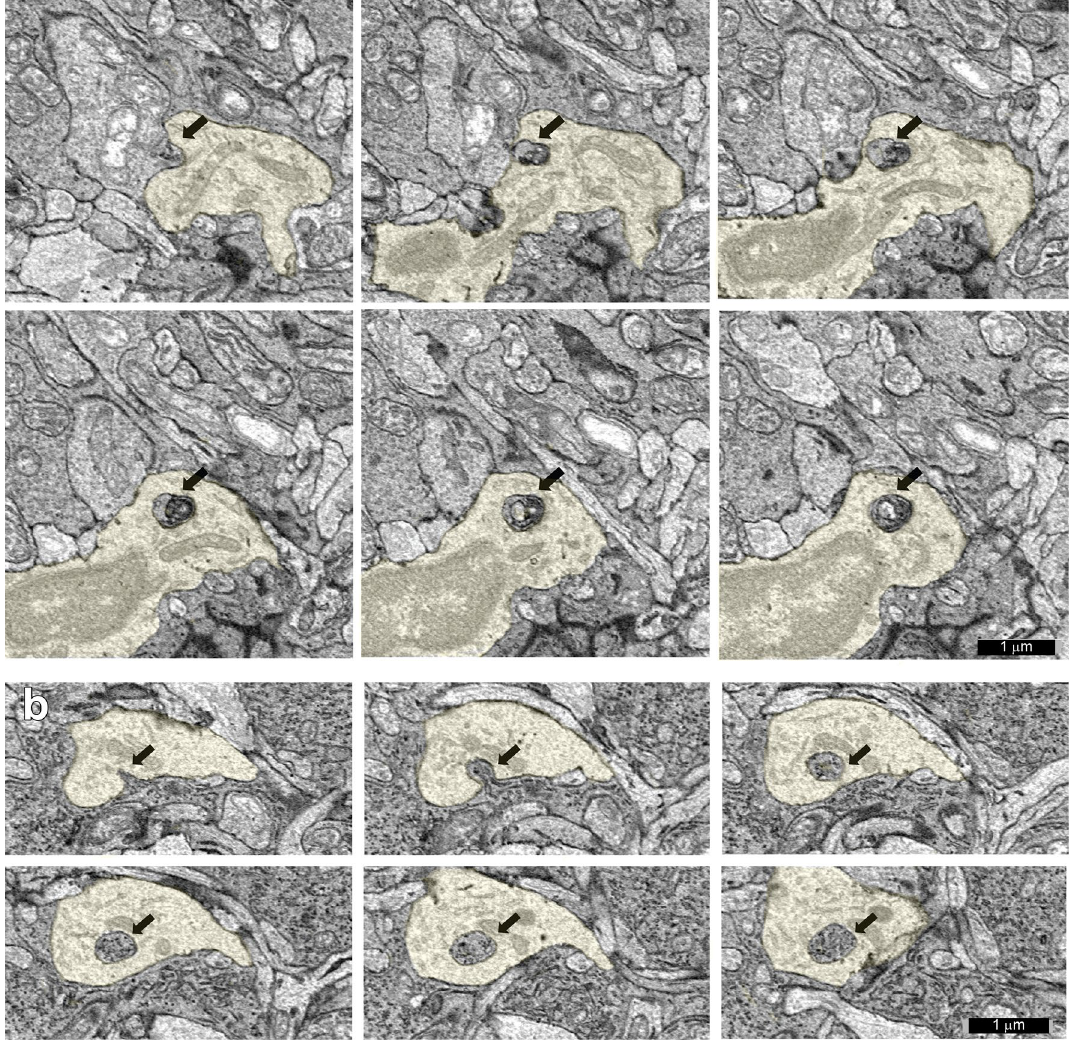
Figure 2. Examples of trogocytosis by processes of microglial cell #50688 (yellow). The ingested material is indicated with an arrow. ( a ) Trogocytosis of a neuron by the microglial cell, location ID: 1305081. ( b ) Trogocytosis of a Müller glial cell by the microglial cell, location ID: